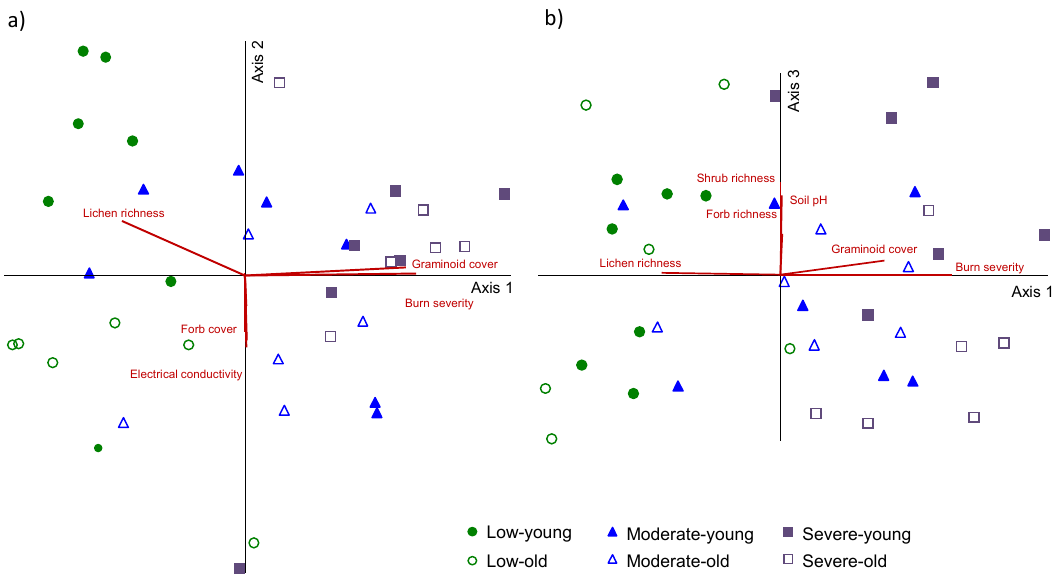
Figure 3. Non ‐ metric multidimensional scaling ordination of all plant community data: ( a ) Axes 1 and 2; ( b ) Axes 1 and 3. The environmental overlays present the most significant relationships for each species group, burn severity and soil chemistry with r > 0.5.